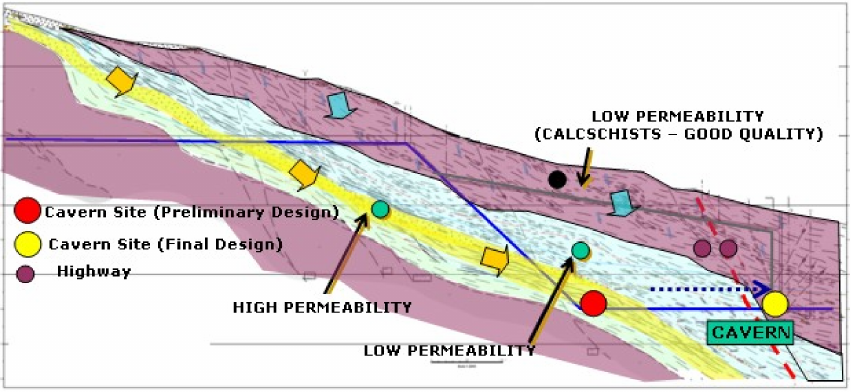
Figure 2. Schematic illustration of the hydro-geological